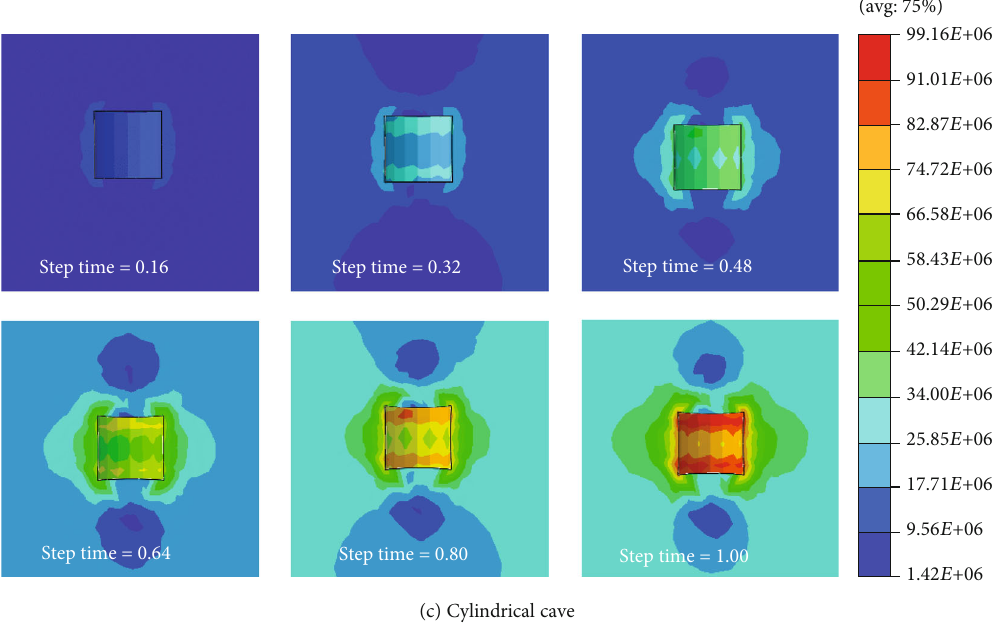
Figure 5: Stress variation processes for three shapes of karst